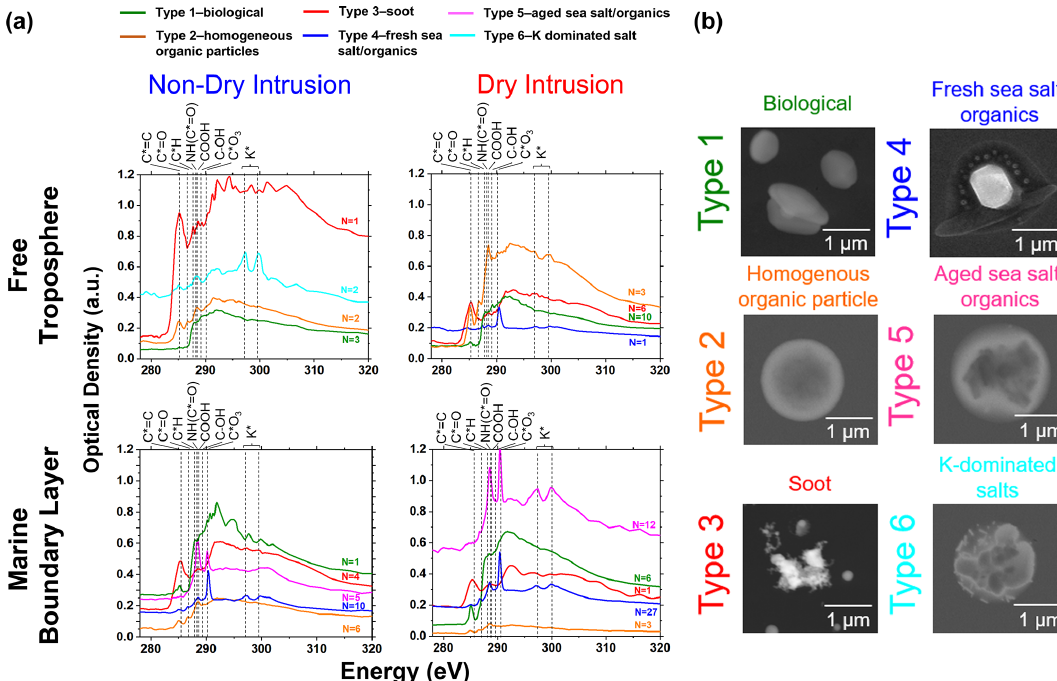
Figure 4. (a) Individual NEXAFS spectra showing differences in carbon content of representative particles collected at MBL and FT altitudes under different synoptic conditions. Identified carbon types are the following: type 1 – biological (green), type 2 – homogeneous organic particles (orange), type 3 – soot (red), type 4 – fresh sea salt–organics (blue), type 5 – aged sea salt–organics (pink), and type 6 – K- dominated salt (teal). Dashed lines correspond to the transition energies: 285.4eV (C ∗ = C), 286.7eV (C ∗ = O), 287.7eV (C ∗ –H), 288.3eV (R-NH(C ∗ = O)R), 288.5eV ( R (C ∗ = O)OH), 289.5eV (RC ∗ –OH), 290.0eV (C edge step), 290.4eV (C ∗ O 3 ), 297.1eV (K ∗ (K ∗ ). (b) Representative secondary electron-mode SEM imaging of particles corresponding to the different carbon types identified with the L 3 STXM/NEXAFS